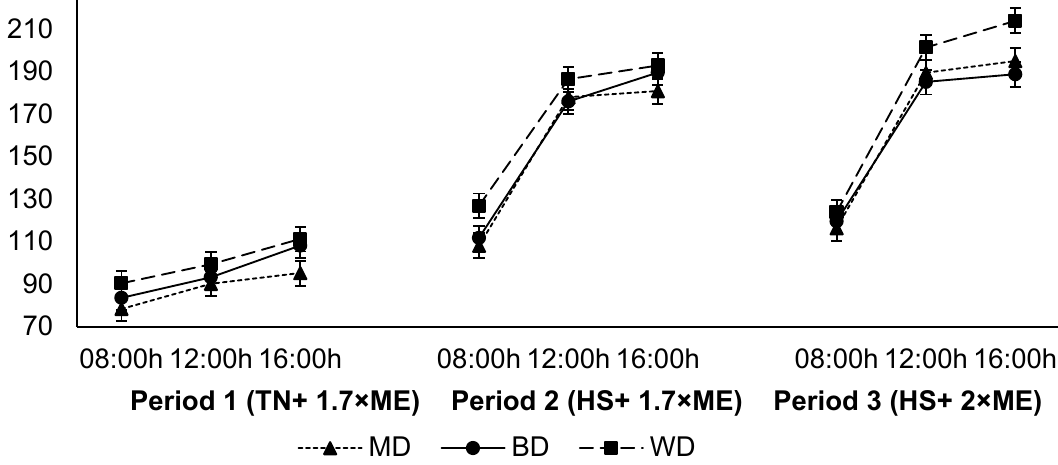
Figure 3. Relationship between respiratory rate, time of observation, and experimental period in sheep fed on different diets. The standard error of the difference for the interaction between period and dietary treatments and time is displayed on the on the graph. The p -values for the effects of diet, period, time, diet * period, diet * time, period * time, and diet * period * time were p < 0.001, p < 0.001, p < 0.001, p = 0.14, p = 0.55, p < 0.001, and p = 0.17. The heart rate increased in response to HS (P1 vs. P2) with no further increase in P3 (84.3, 89.0, and 89.2 (SED 2.15) beats/min for P1, P2, and P3, respectively; p <